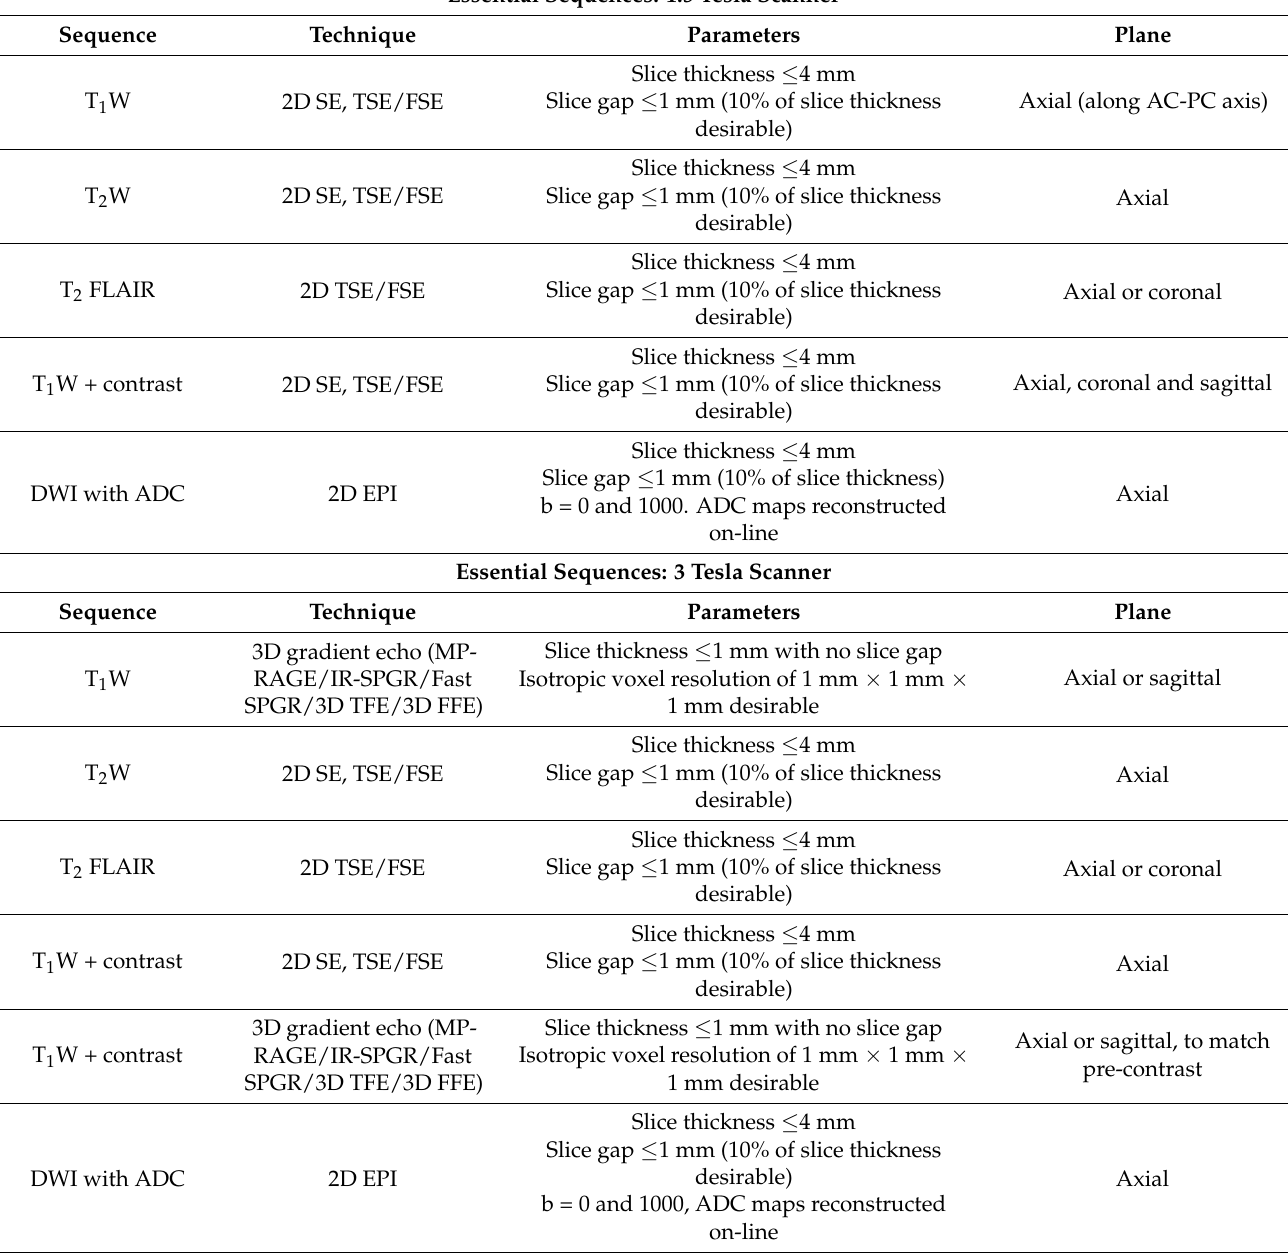
Table 1. Essential and optional brain Magnetic Resonance Imaging sequences. * 3D FLAIR can be used instead of 2D FLAIR but not if 2D sequences have been used for the same individual on previous occasions. ** The heavily weighted T 2 W sequence localised to a region of interest is useful in assessment of lesions (in particular poorly/non-enhancing) within the extra-axial space or along the parenchymal surface. SE, Spin Echo; TSE, Turbo Spin Echo; FSE, Fast Spin Echo; MP-RAGE, Magnetisation-Prepared Rapid Gradient-Echo; IR, Inversion Recovery; SPGR, Spoiled Gradient Recalled echo; TFE, Turbo Field Echo; FFE, Fast Field Echo; DWI, diffusion-weighted imaging; ADC, Apparent Diffusion Coefficient; EPI, Echo Planar Imaging; CISS, Constructive Interference in Steady State; bFFE, balanced Fast Field Echo; FIESTA, Fast Imaging Employing Steady-state Acquisition; DTI, Diffusion Tensor Imaging; NA, not applicable. Essential Sequences: 1.5 Tesla Scanner